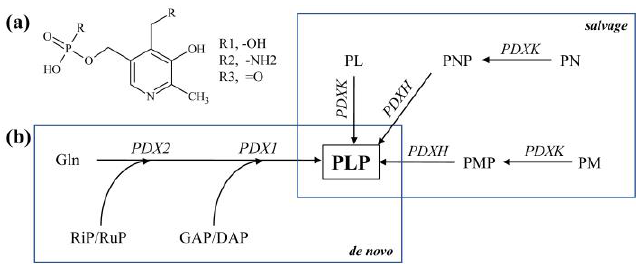
Figure 2. Vitamin B 6 biosynthesis in higher plants. ( a ) Chemical structure of phosphorylated B 6 vitamers. ( b ) Vitamin B 6 de novo biosynthesis and salvage pathways. Both pathways are present in the cytosol. Because it is unclear whether they are also active in the chloroplasts, we did not assign a specific cellular localization for either pathway. Either RiB or RuP, as well as GAP or DAP, can be used. phosphate; RuP, ribulose 5 (cid:48) -phosphate; RiP, ribose 5 (cid:48) -phosphate; DXP, deoxyxylulose 5 (cid:48) -phosphate; Gln, glutamine; PL, pyridoxal; PLP, pyridoxal 5 (cid:48) -phosphate; PM, pyridoxamine; PMP, pyridoxamine 5 (cid:48) -phosphate; PN, pyridoxine; PNP, pyridoxine 5 (cid:48) -phosphate; PDXK, pyridoxine kinase; PDXH, pyridoxine